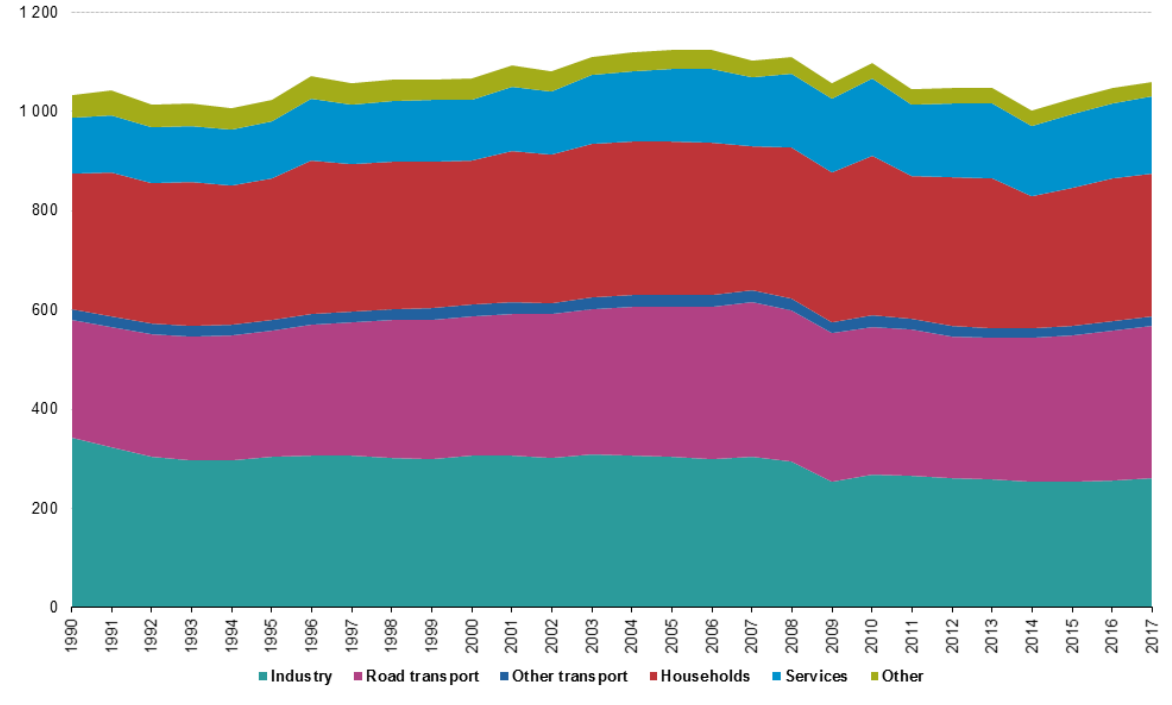
Figure 2: Final energy consumption by sector (million tonnes of oil equivalent)